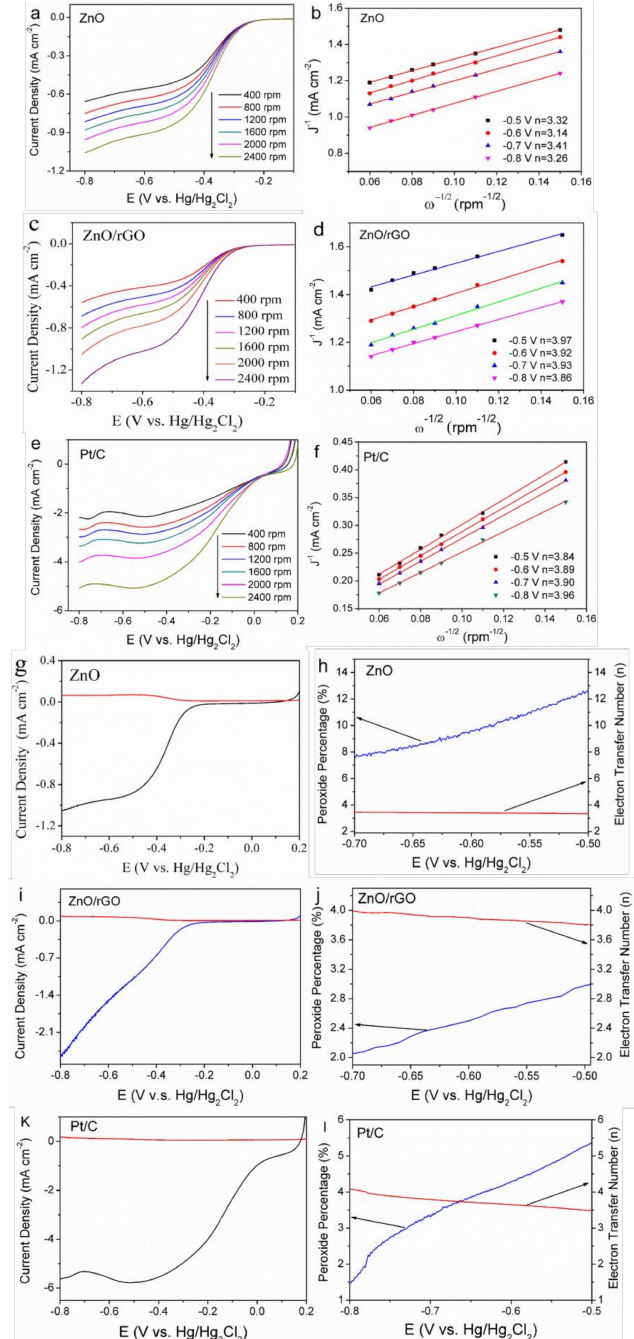
Figure 4. Investigating of ORR Mechanism on catalysts: ( a , c , e ) RDE profiles of ZnO, ZnO/rGO and commercial Pt/C catalyst, respectively in O 2 -saturated 0.1 M KOH solution at various rotation rates ranging from 400 to 2400 rpm, along with ( b , d , f ) their corresponding Koutecky-Levich plots at different potentials. RRDE profiles ( g , i , k ) in O 2 -saturated 0.1 M KOH solution at a rotation rate of 1600 rpm. Percentage of peroxide and the electron transfer number ( h , j , l ) at various potentials. Scan rate: 5